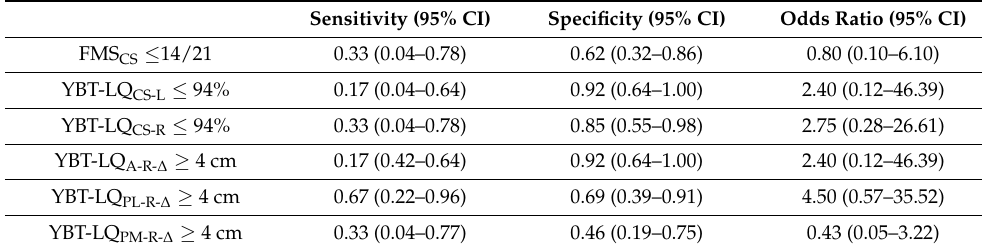
Table 7. Indicators of injury risk predictive value for FMS and